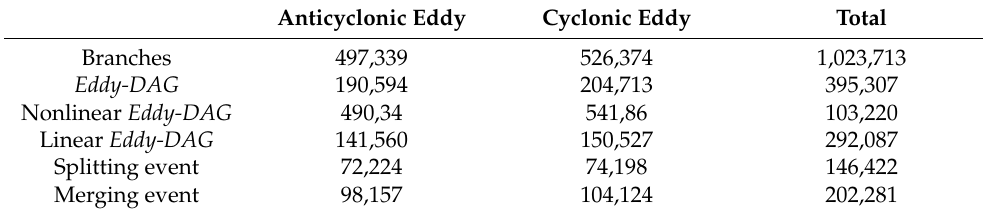
Table 1. The numbers of branches and Eddy-DAGs of anticyclonic and cyclonic eddies during